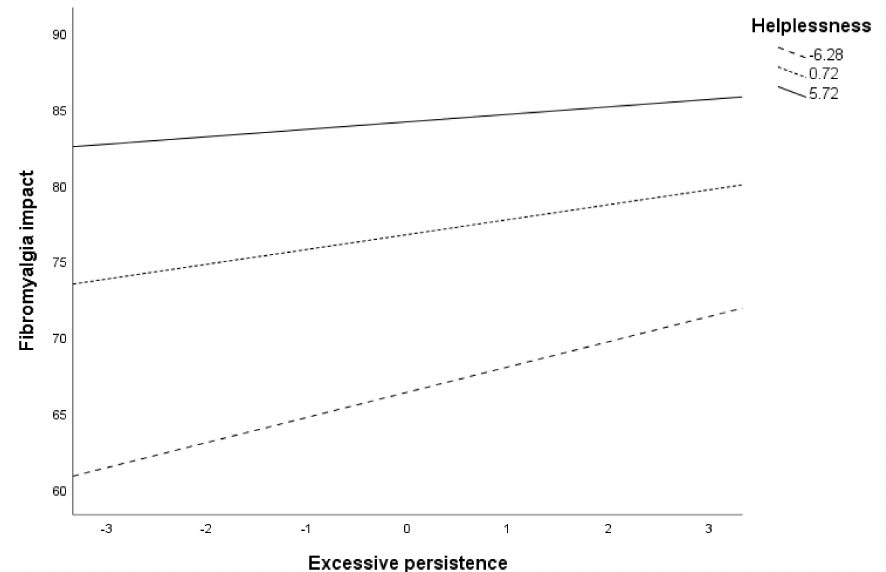
Figure 3. Conditional effects of excessive persistence on fibromyalgia impact at different val- ues of